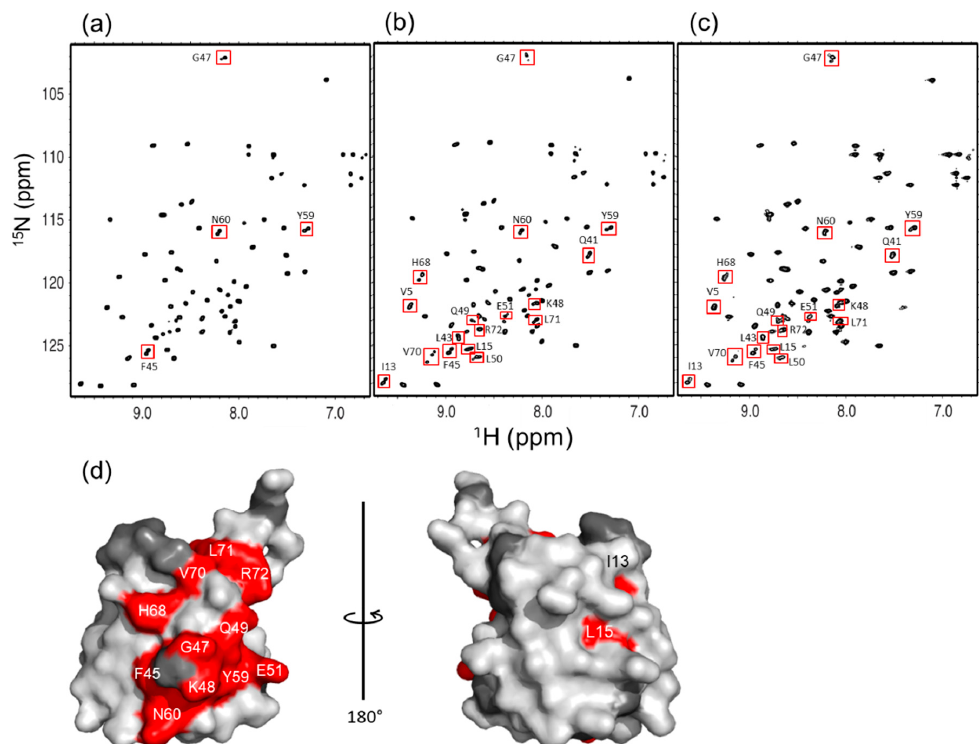
Figure 4. 1 H- 15 N HSQC spectra of uniformly 15 N-labeled ( a ) n-diUb, ( b ) n-triUb, and ( c ) n-tetraUb. Multiple peaks (boxed) are displayed. ( d ) Mapping of the 3D structure of monomeric Ub (PDB: 1UBQ), with residues showing the multiple peaks. The proline residues and the residues whose 1 H- 15 N HSQC peaks could not be observed as probes because of broadening and / or overlapping are shown in gray.